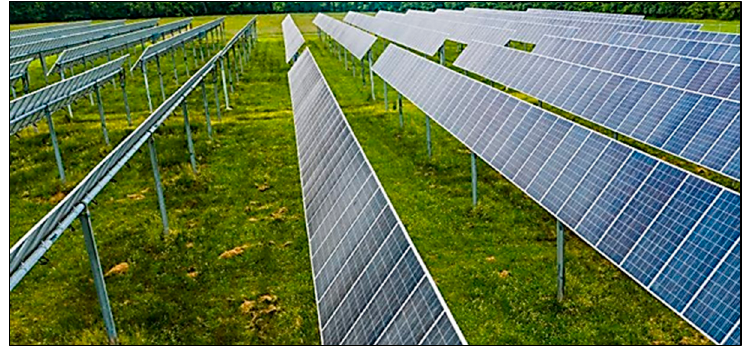
Figure 7. Using solar panels in agriculture sector.